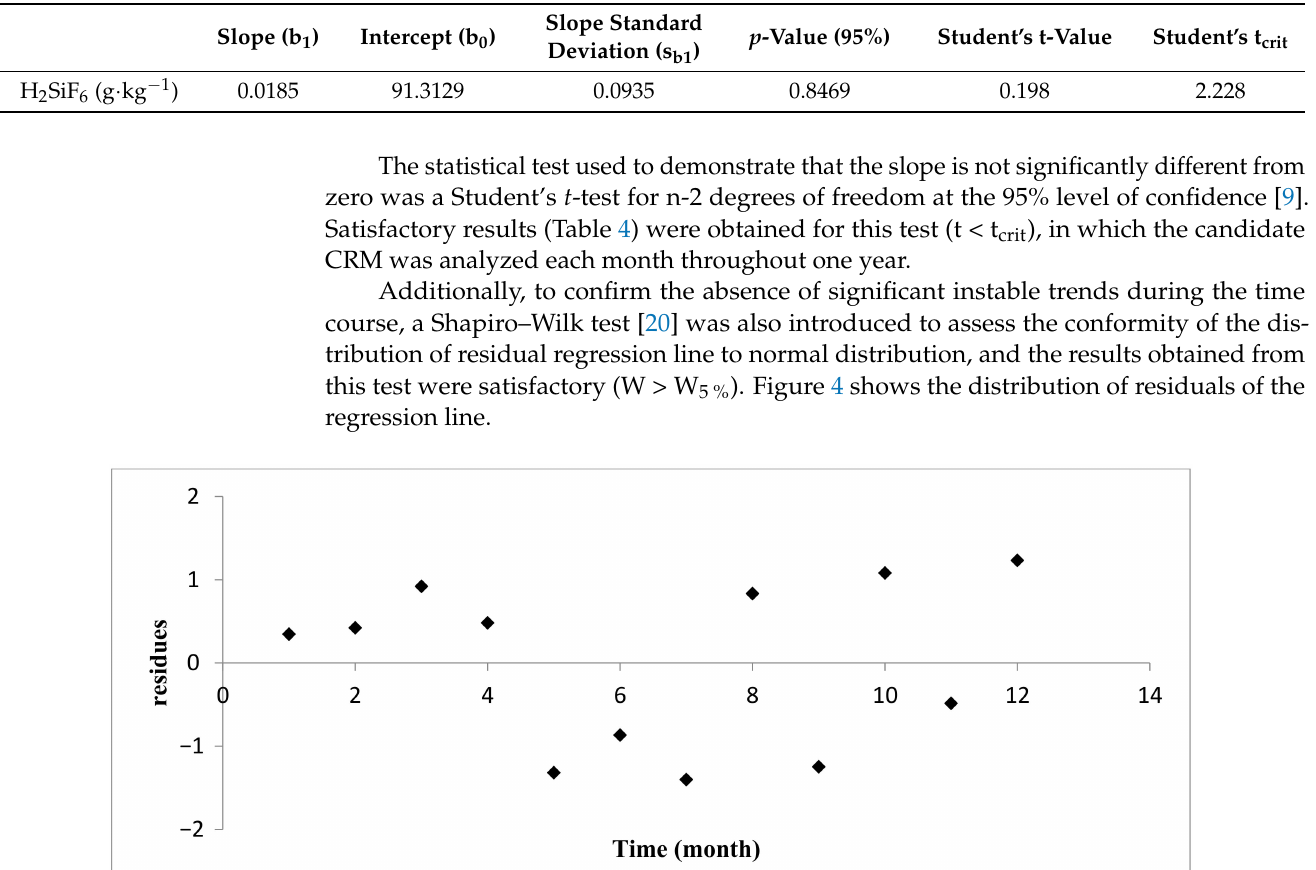
Table 4. Linear regression analysis of the long–term stability.